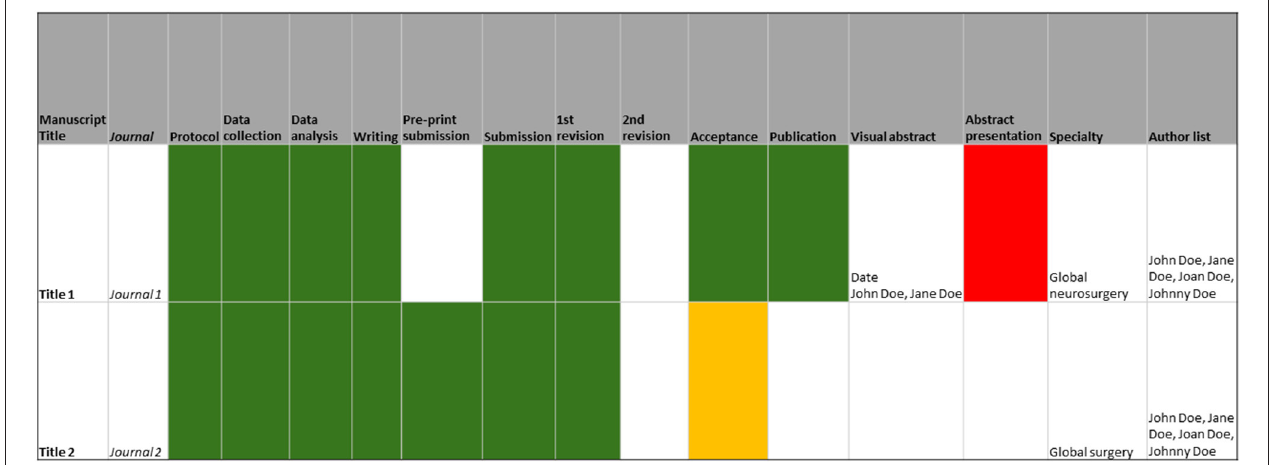
FIGURE 2 | Research track sheet showing checkpoints of the research cycle with completion and deadlines. Completion is color coded: green (completed task), orange (uncompleted task and deadline past), red (major setback), and white (previous task has not been